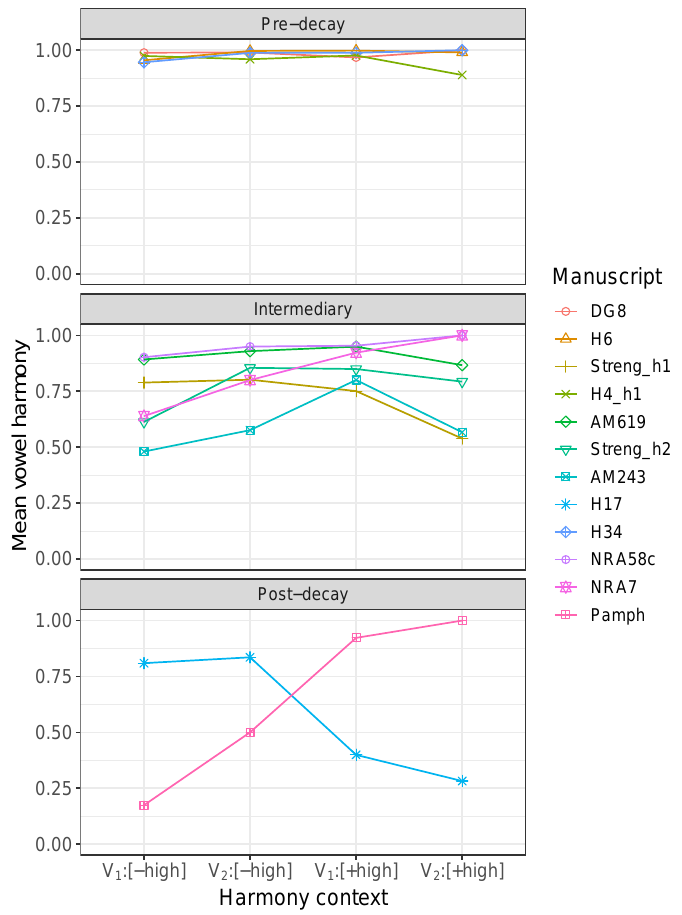
Figure 12: Contribution of sequence number and trigger vowel height to harmonic correspondence in pre-decay, intermediary, and post-decay